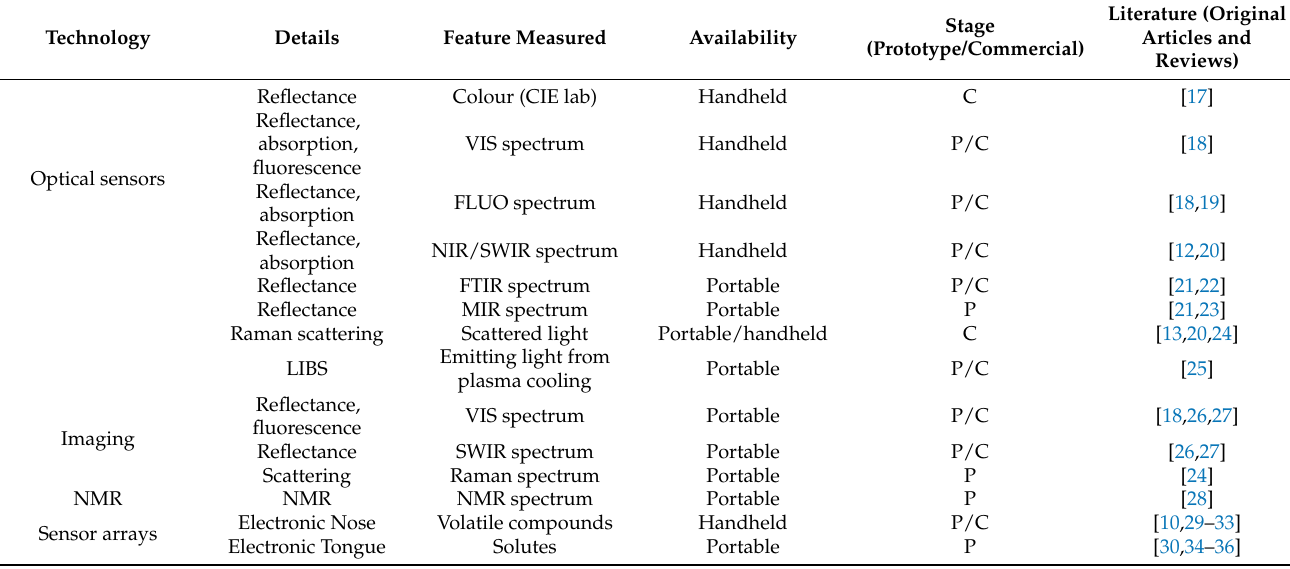
Table 1. Technologies for food authentication available in miniaturised form: variants of optical sensors, imaging sensors, sensor arrays, and NMR devices.